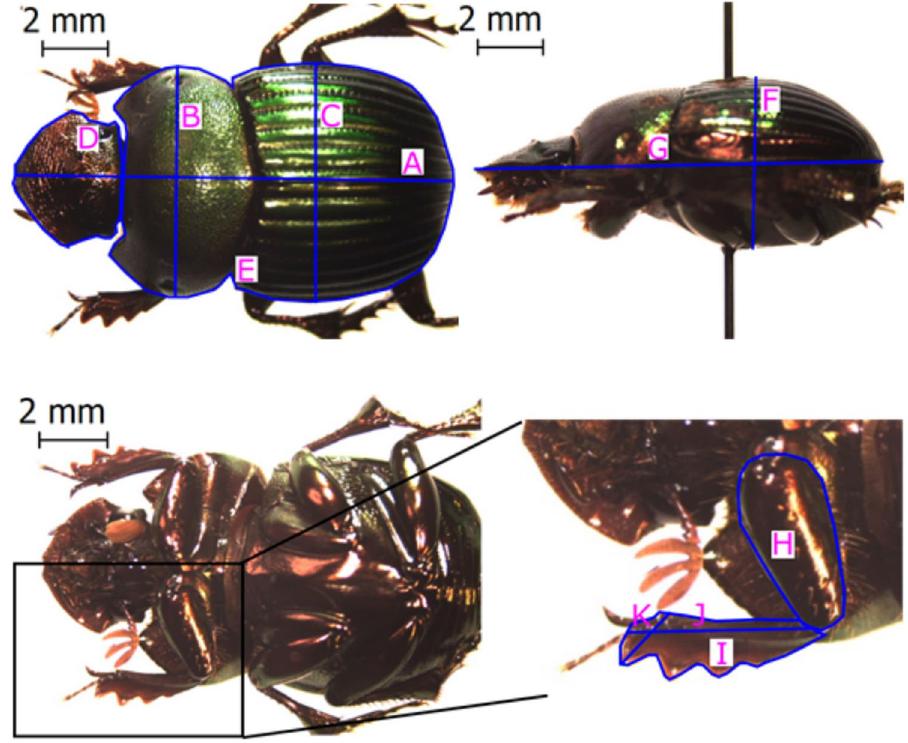
Figure 1. Dorsal, lateral, and ventral view of Chalcocopris hesperus. A: Total length, B: Pronotum width, C: Elytra width, D: Head area, E: Body area, F: Depth, G: Lateral length, H: Femur area, I: Anterior tibia area, J: Anterior tibia length, K: Width of the largest tooth in the anterior tibia.